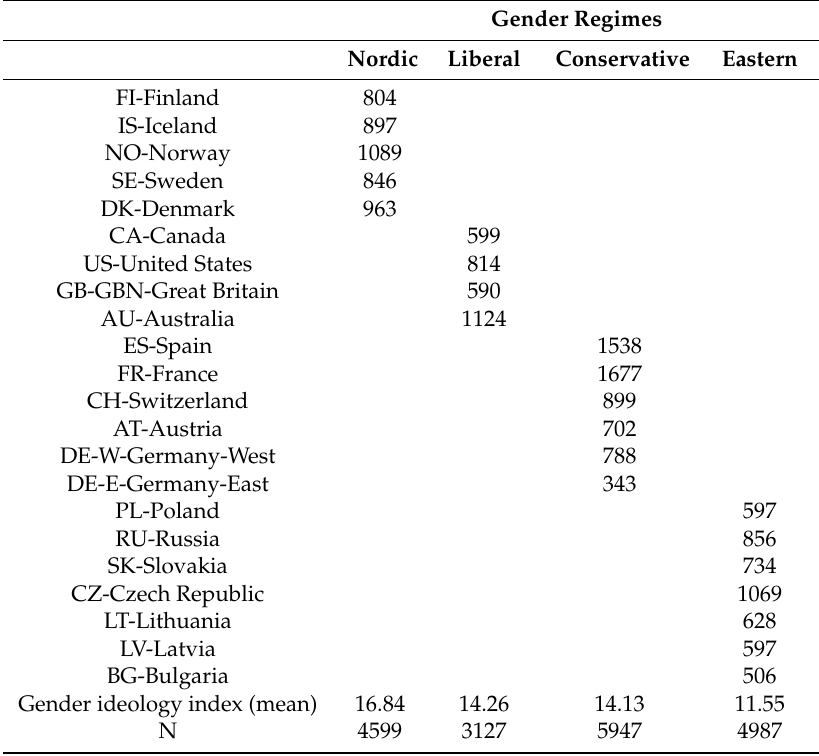
Table 1. Countries included in different types of gender regimes and number of respondents who are